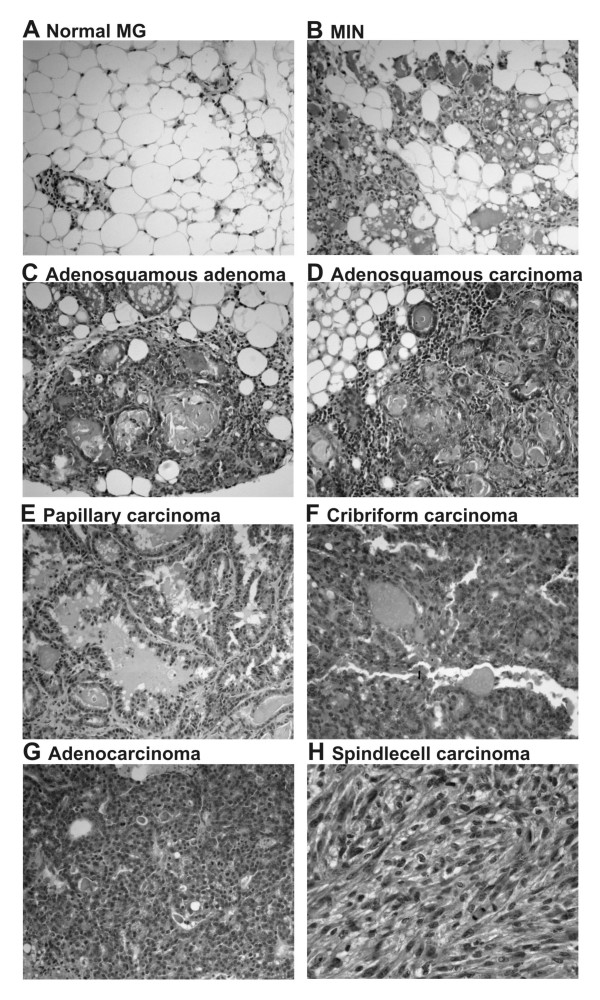
Abnormal mammary gland morphology. Photographs of HE stained sections of representative abdominal mammary glands of post-weaned multiparous mice with (A) normal mammary gland epithelium; (B) mammary intraepithelial neoplasia (MIN); (C) hyperplastic alveolar nodules (HAN) or adenosquamous adenoma; (D) adenosquamous carcinoma; (E) papillary carcinoma; (F) cribriform carcinoma; (G) adeno carcinoma; and (H) spindle cell carcinoma. All pictures are taken with the same magnification except (H), which is taken with a two times higher magnification.